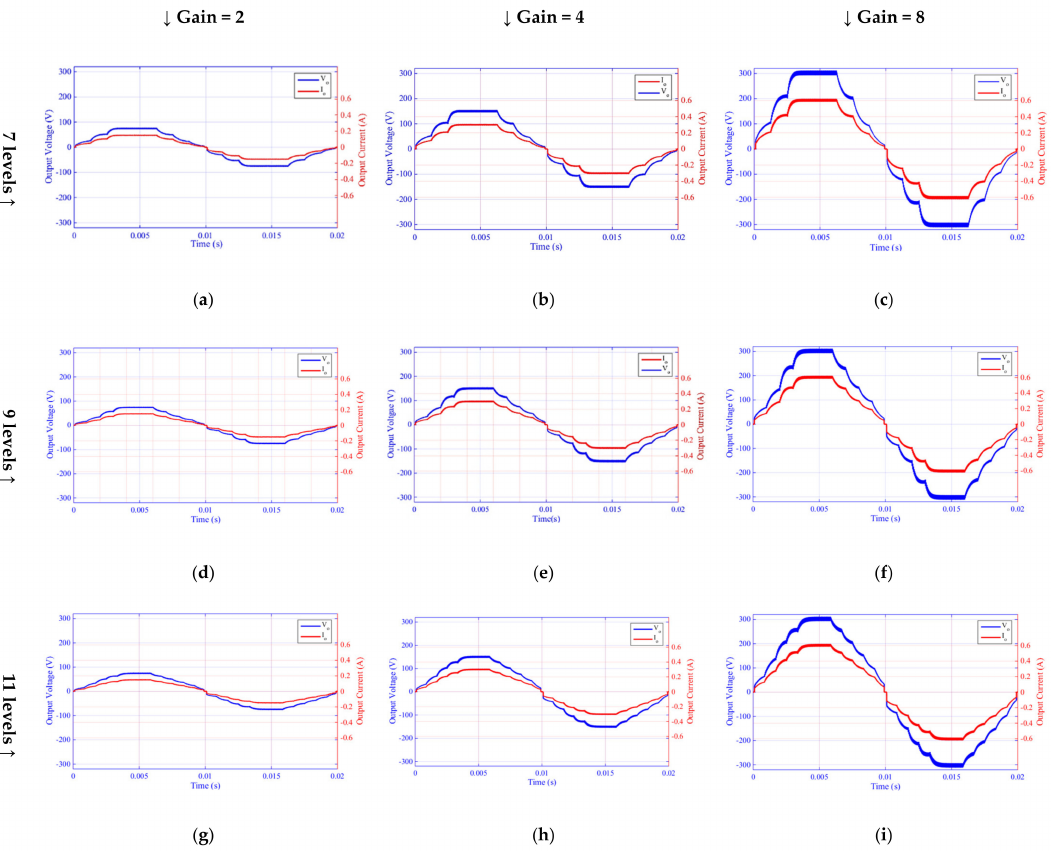
Figure 7. Simulation waveform of output voltages and currents for the proposed multilevel inverter: ( a ) levels = 7, gain = 2; ( b ) levels = 7, gain = 4; ( c ) levels = 7, gain = 8; ( d ) levels = 9, gain = 2; ( e ) levels = 9, gain = 4; ( f ) levels = 9, gain = 8; ( g ) levels = 11, gain = 2; ( h ) levels = 11, gain = 4; ( i ) levels = 11, gain = 8.